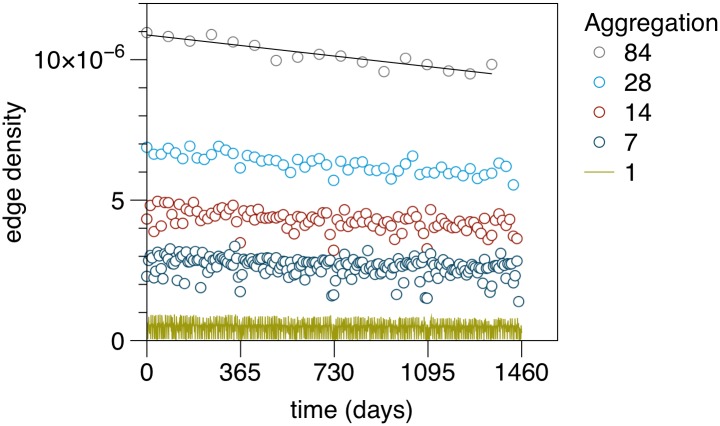
Development of the edge density.There is a clear trend to edge reduction over time. The edge density of the static network is 3 × 10−5.